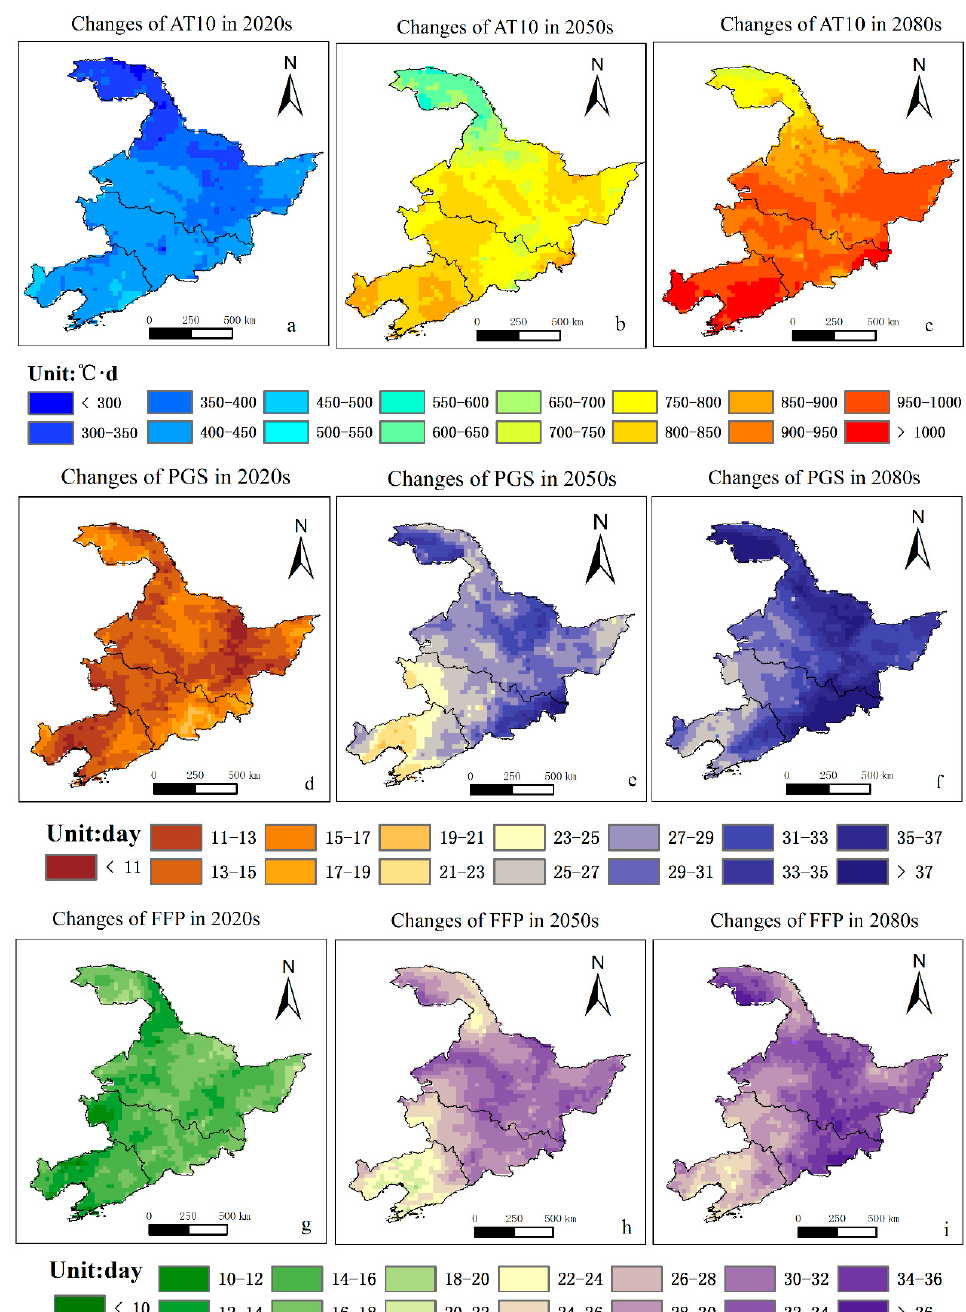
Figure 6. Changes of the AT10, PGS and FFP compared with the baseline period over the 21st century: ( a ) changes of AT10 in 2020s; ( b ) changes of AT10 in 2050s; ( c ) changes of AT10 in 2080s; ( d ) changes of PGS in 2020s; ( e ) changes of PGS in 2050s; ( f ) changes of PGS in 2080s; ( g ) changes of FFP in 2020s; ( h ) changes of FFP in 2050s; ( i ) changes of FFP in 2080s.